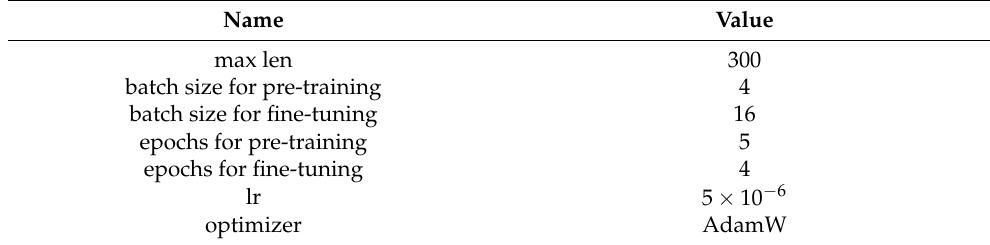
Table 3. Parameter settings for